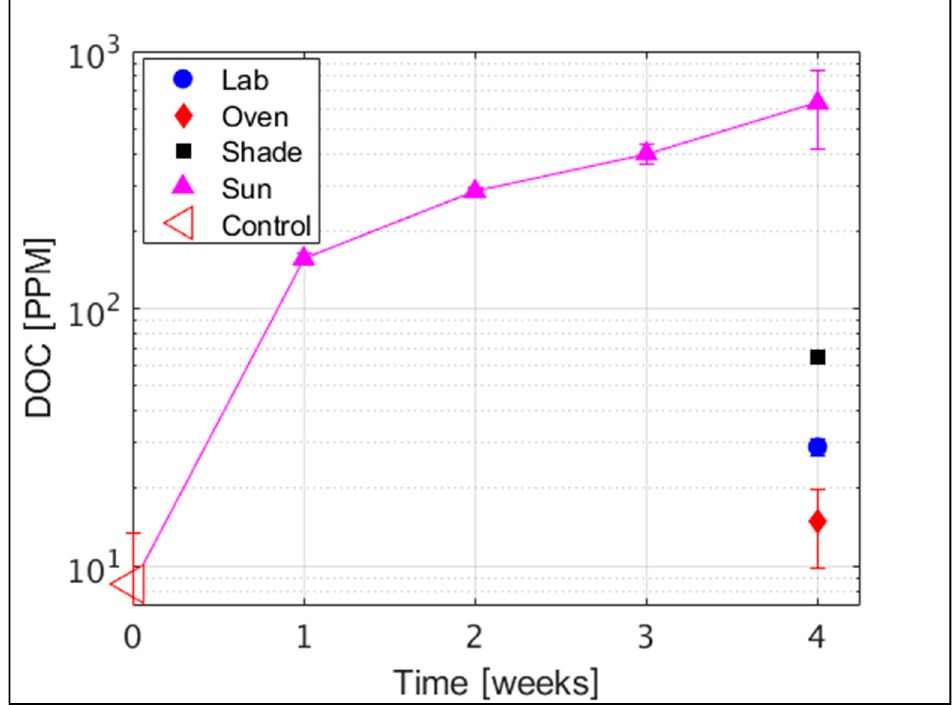
Figure 7. DOC concentrations for the ‘Sun’ setup throughout the entire length of the experiment and for the ‘Lab’, ‘Oven’, and ‘Shade’ setups at the fourth week of the experiment.